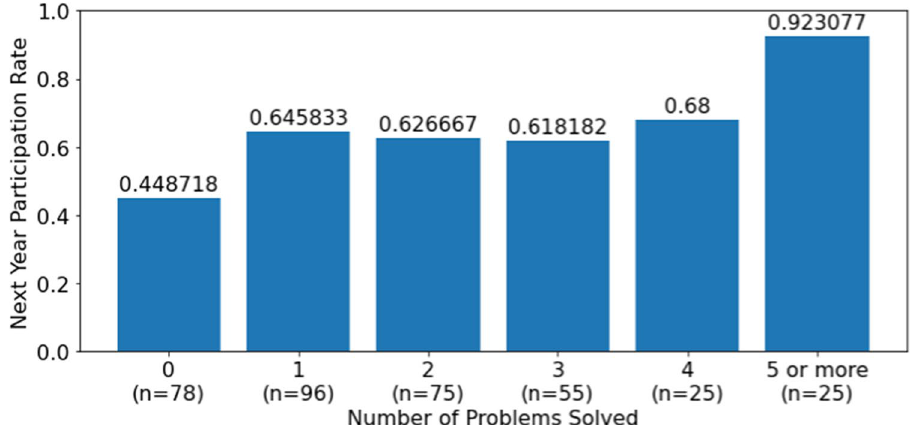
Fig. 6 Return rate for institu- tions participating in first contest in at least 3 years, and sending only one team, as a function of the number of problems correctly